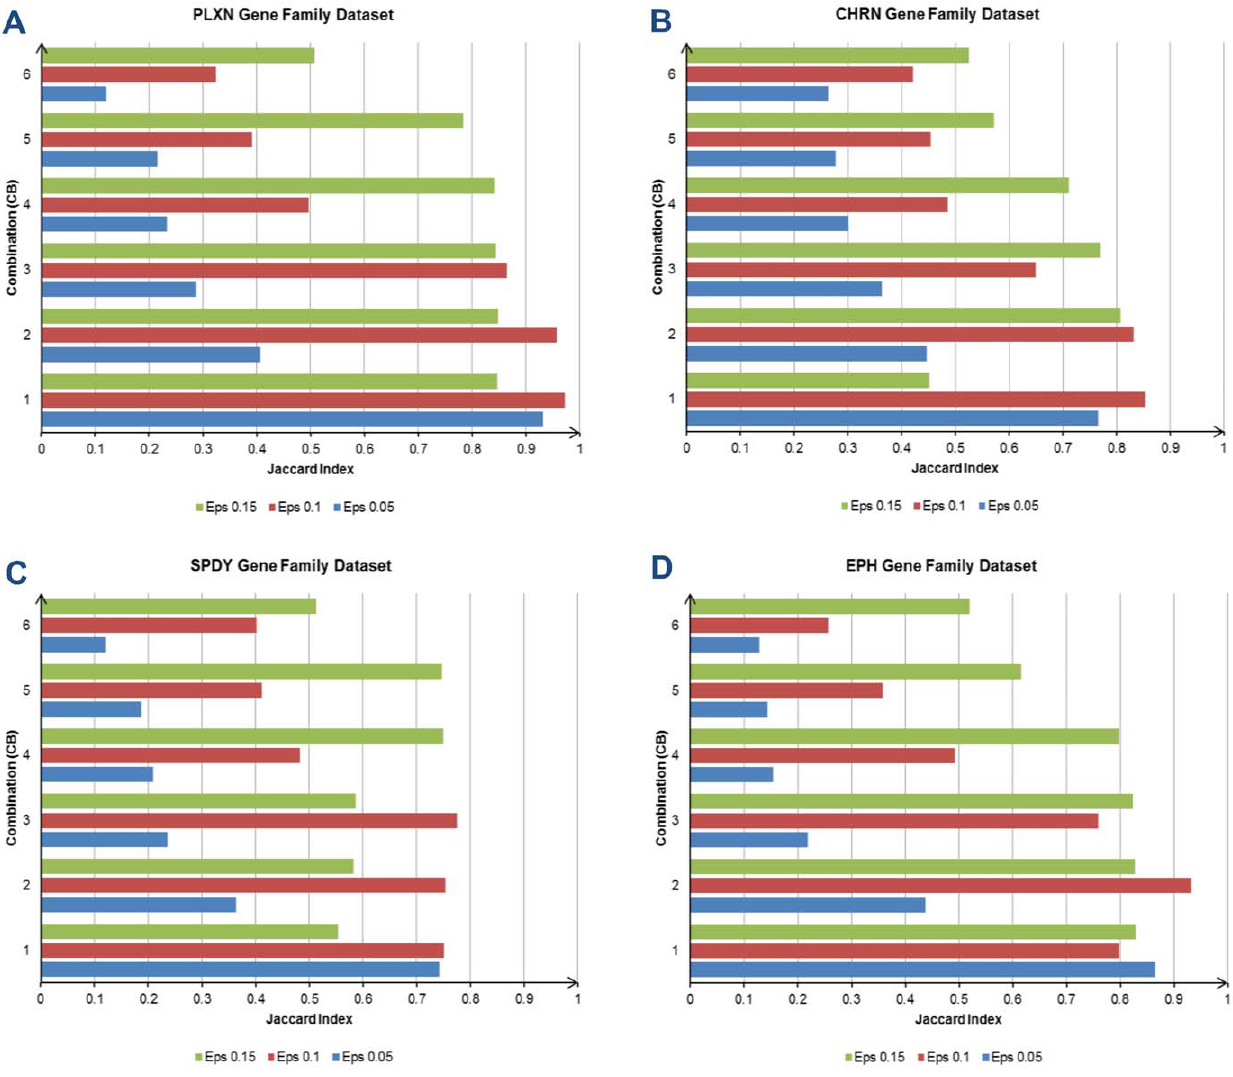
Figure 7. The clustering results (Jaccard Index) for the other four experimental EST datasets. (A) shows the plotted clustering result for the PLXN. The test with combination CB1 and neighborhood distance (Eps) 0.1 is the best performer in this dataset. The second highest clustering accuracy is recorded by the test with CB2 and Eps 0.1. The clustering result for the CHRN dataset is displayed in (B). The test with CB1 and Eps 0.1 sets the highest clustering accuracy (0.8527) in this dataset, while the test with CB2 and Eps 0.1 delivers the second best clustering accuracy. (C)–(D) denotes the clustering results for the SPDY and EPH datasets. In SPDY dataset, the highest clustering accuracy is achieved by the test with CB3 and Eps 0.1. It is followed by the test with CB2 and Eps 0.1. For the EPH dataset, the best clustering accuracy is done by the test with CB2 and Eps 0.1. The test with CB1 and Eps 0.05 produces the second best clustering accuracy.